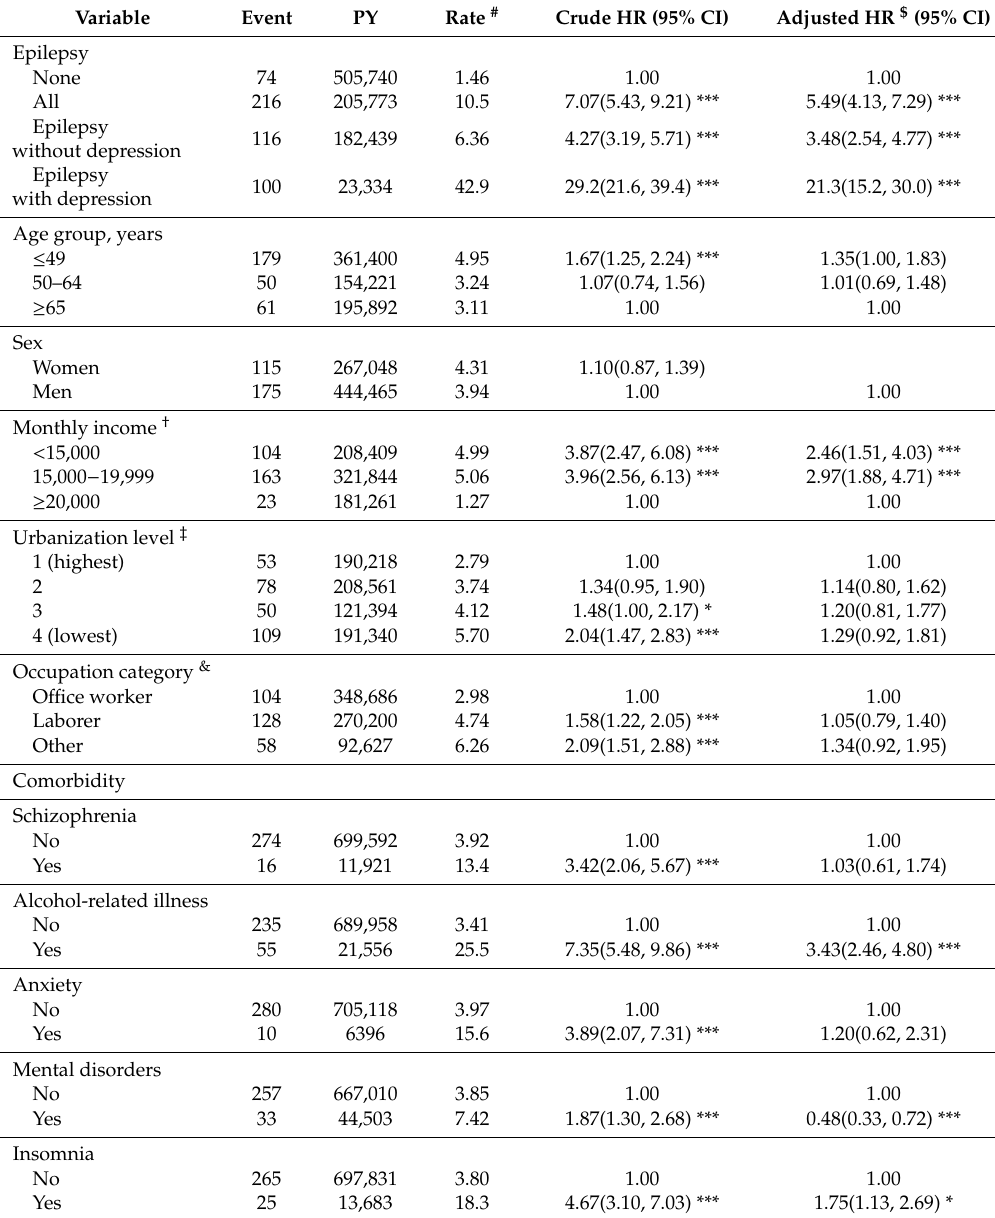
Table 2. Association of incidence and risk of SA with various risk